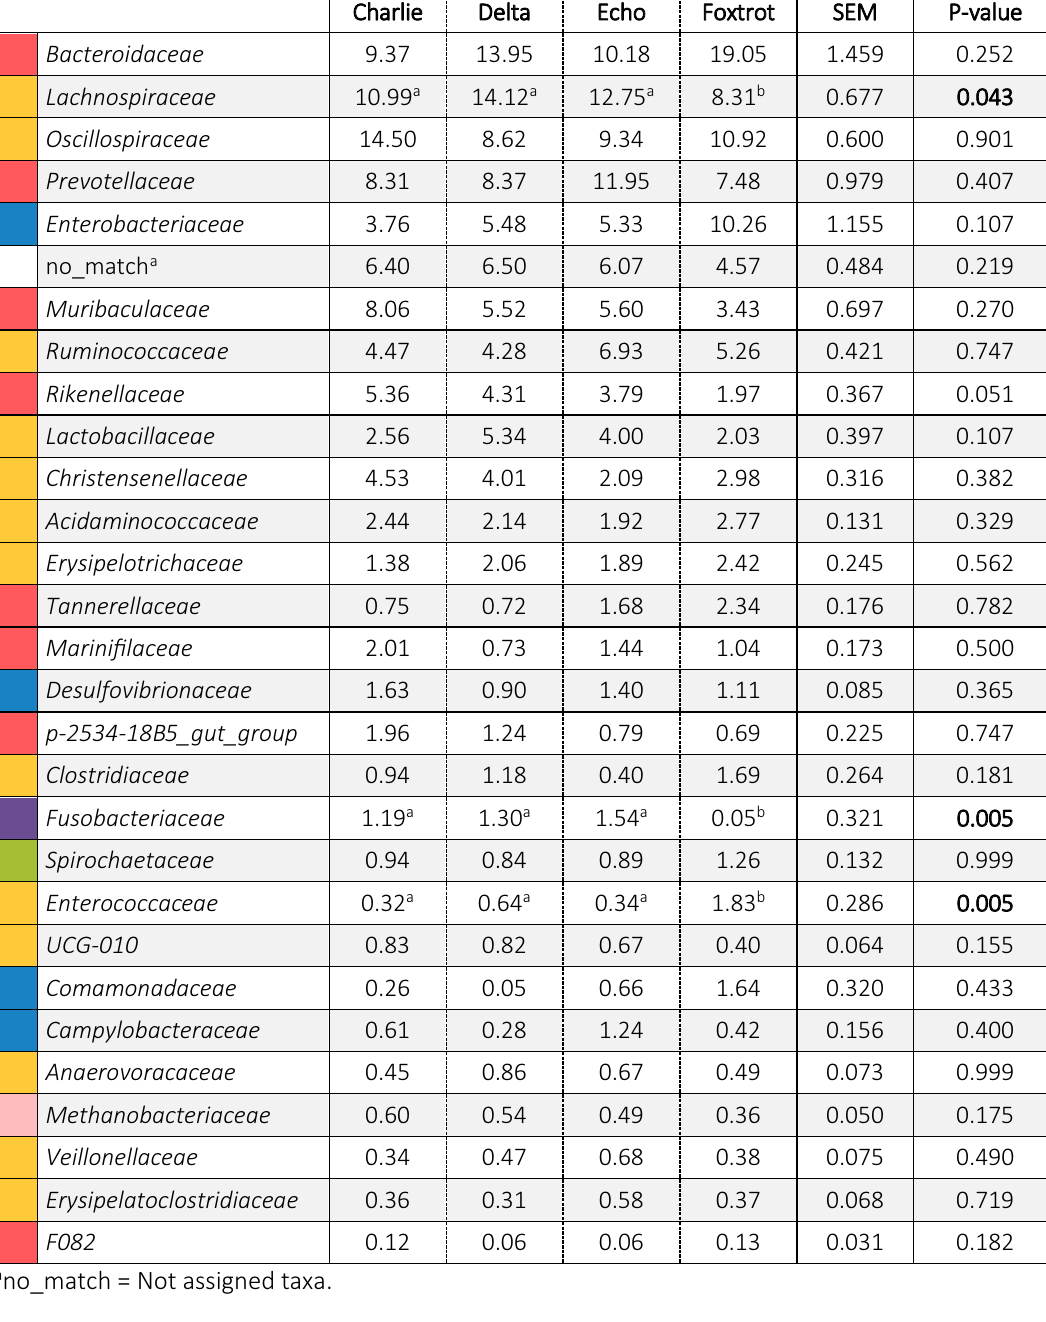
Table 4 Relative abundances (%) of the families present in the faecal microbiota of 21‑day‑old piglets from Trial 2 in a percentage higher than 0.5%, classified by farm and in decreasing order of abundance in relation to the general